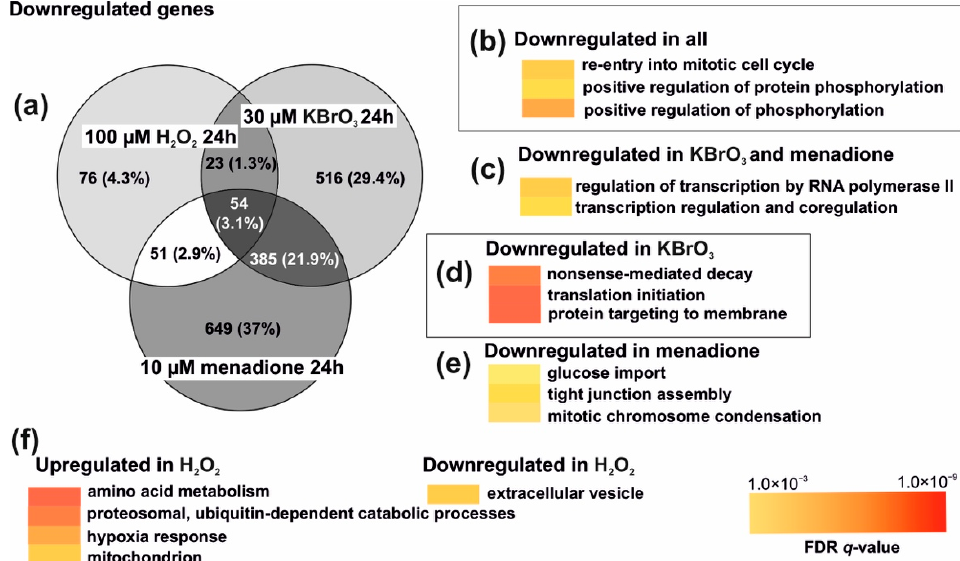
Figure 4. Different oxidative insults have common features. ( a ) A Venn diagram showing the number of common and private, significantly down-regulated genes after menadione, KBrO 3 , or H 2 O 2 treatment. ( b ) Among the 54 genes downregulated after the exposure to each of the three chemicals were genes that are involved in cell cycle regulation and cell signaling. ( c ) Both menadione- and KBrO 3 -treated cells showed general inhibition of transcription, while ( d ) KBrO 3 alone also induced downregulation of translation. ( e ) Menadione had relatively few privately affected processes, among these glucose imports. The 76 genes downregulated in H 2 O 2 -treated cells did not show any significant enrichment of specific cellular processes. ( f ) In contrast, H 2 O 2 -treated cells showed a significant upregulation of genes involved in amino acid metabolism, hypoxia response and protein catabolism.